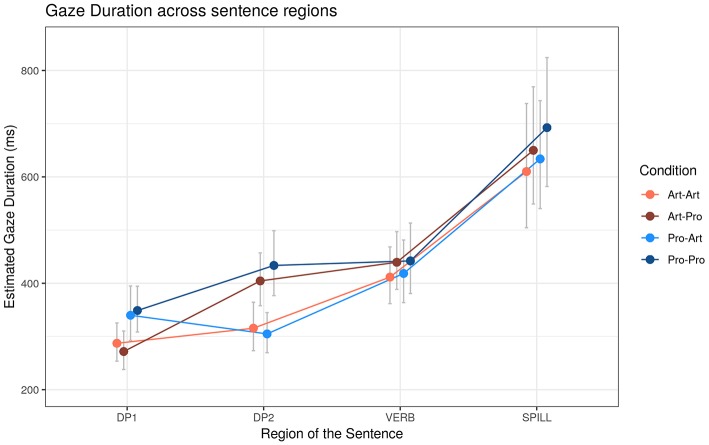
Estimated Gaze Duration (GD) reading times (ms) across sentence regions. Error bars represent 95% confidence intervals around the models' estimates.